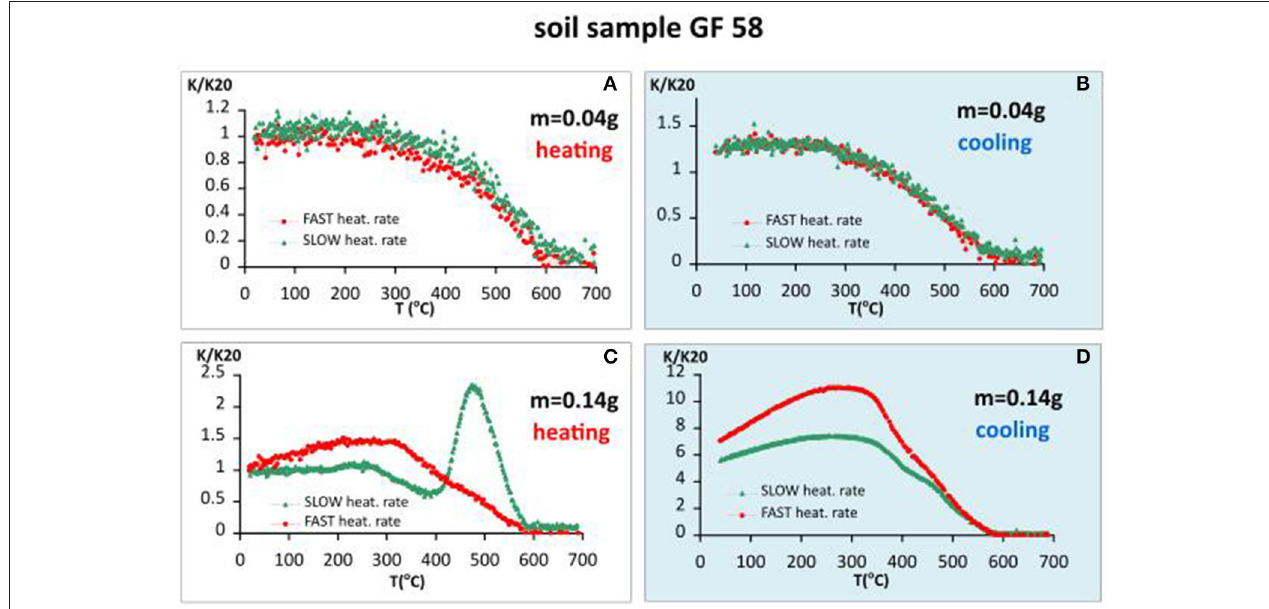
FIGURE 1 | Thermomagnetic analysis of magnetic susceptibility for soil sample GF58, heating in air. (A) Heating curves using fast and slow heating rates for small sample size ( m = 0.04g); (B) cooling curves using fast and slow heating rates for small sample size; (C) heating curves using fast and slow heating rates for large sample size ( m = 0.14g); (D) cooling curves using fast and slow heating rates for large sample size.